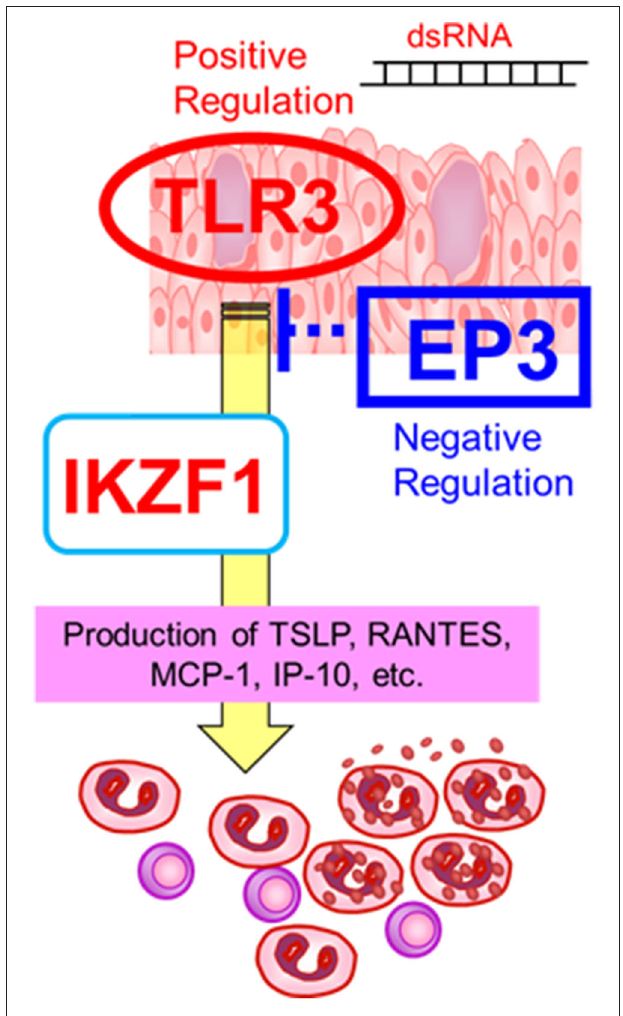
FIGURE 2 | Gene–gene interactions. The susceptibility genes such as TLR3 , PTGER3 , and IKZF1 , might contribute the mucocutaneous inflammation of SJS/TEN with SOC. Reprinted with permission from Ueta et al. (